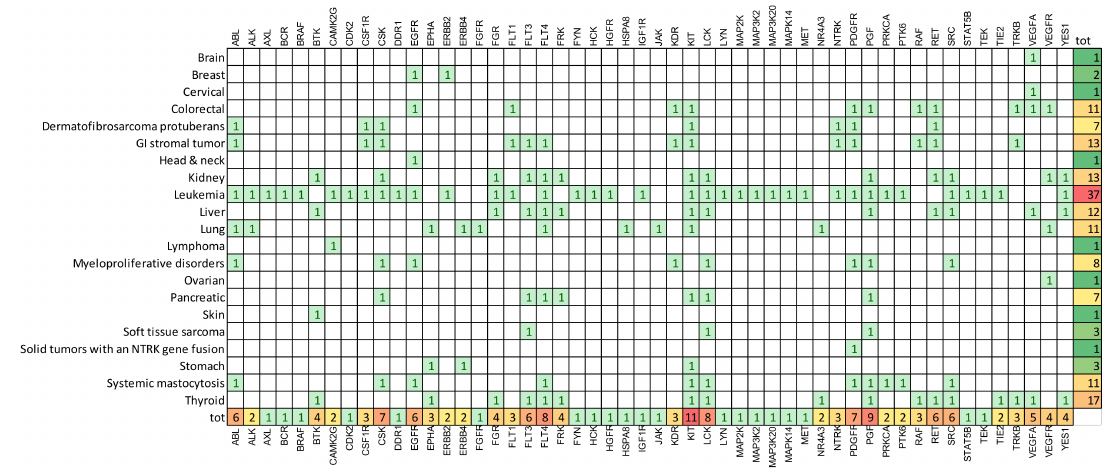
Figure 2. Tyrosine kinases targeted for different cancers by drugs approved in the clinic. The color gradient (from green to red) indicates the abundancy of the target for each cancer (right) or the frequency of the same target in different cancers